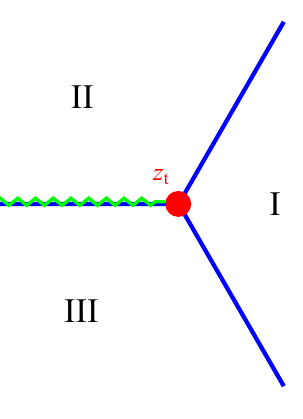
Figure 6 . Stokes graph for Airy potential with the case arg[ ξ ] = 0